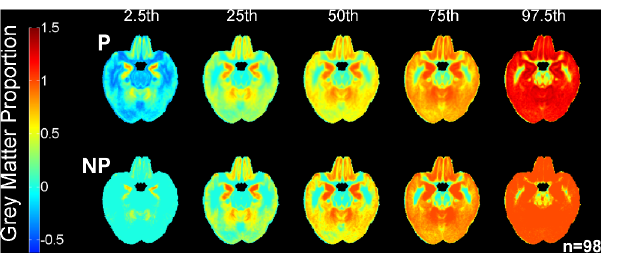
Fig 8. Atlases of the distribution of the proportions of GM in normal older subjects. These were calculated with parametric (mean ± SD; P — upper panel) and nonparametric (order-based; NP — lower panel) methods in 98 aged normal subjects (60 – 90 years)